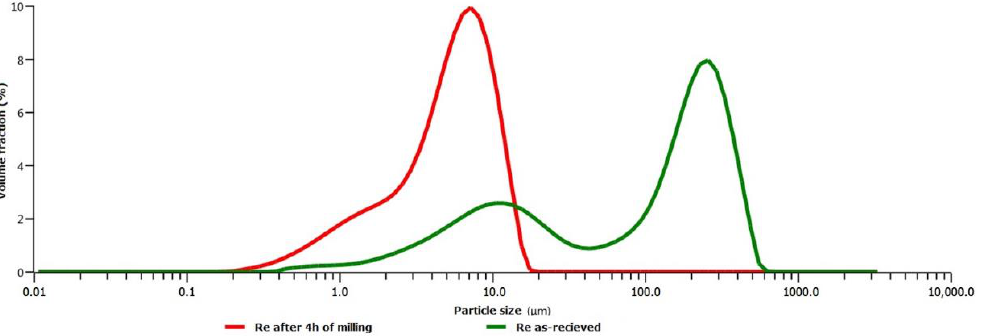
Figure 2. Comparison of the particle size distribution of Rhenium powder in as-received state and after 4 h of milling.